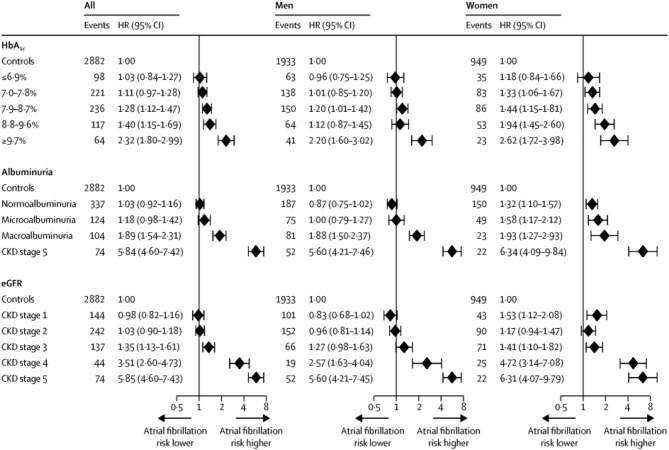
Risk of AF in Type I DM vs. controls based on HbA1c category, albuminuria category, and chronic kidney disease (CKD) stage. CKD stages 1–4 are based on eGFR (estimated glomerular filtration rate): CKD stage 1—eGFR ≥ 90 mL/min per 1.73 m2; CKD stage 2—eGFR 60–89 mL/min per 1.73 m2; CKD stage 3—eGFR 30–59 mL/min per 1.73 m 2; CKD stage 4—eGFR 15–29 mL/min per 1.73 m2;CKD stage 5—eGFR < 15 mL/min per 1.73 m2 or need for dialysis or kidney transplantation. Diamonds indicate HRs and error bars the 95% CIs. Reproduced with permission from Dahlqvist et al. (2017).